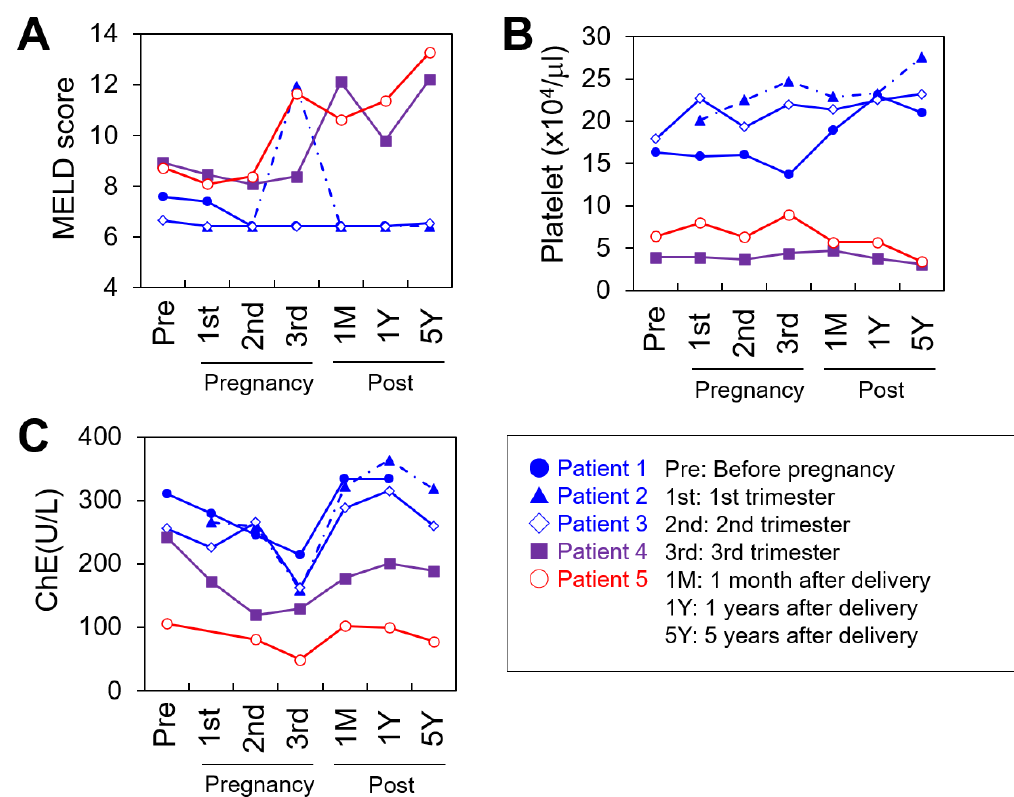
Figure 1. The model for end-stage liver disease (MELD) score ( A ), platelet count ( B ), and cholinesterase (ChE) plot ( C ) during the perinatal period. Pre: Before pregnancy, 1st: 1st trimester, 2nd: 2nd trimester, 3rd: 3rd trimester, 1M: 1 month after delivery, 1Y: 1 year after delivery, 5Y: 5 years after delivery.